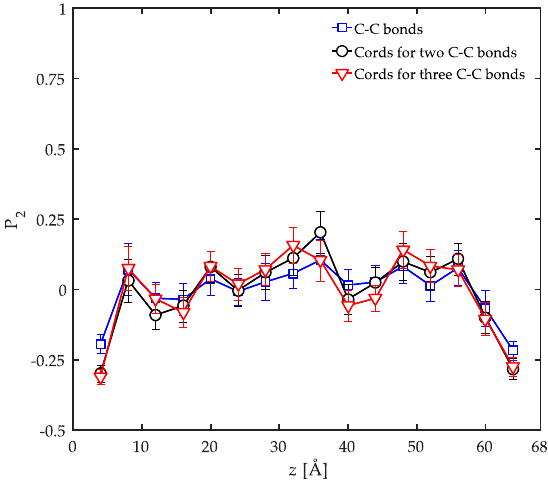
Figure 6. Local order parameter ( P 2 ) as a function of distance from the surface of the substrate for C–C bonds of the backbone (squares), cords connecting two C–C bonds (circles), and cords connecting three C–C bonds (triangles). The results are calculated for the confined PP/Fe 2 O 3 system at 458 K and 1 atm.